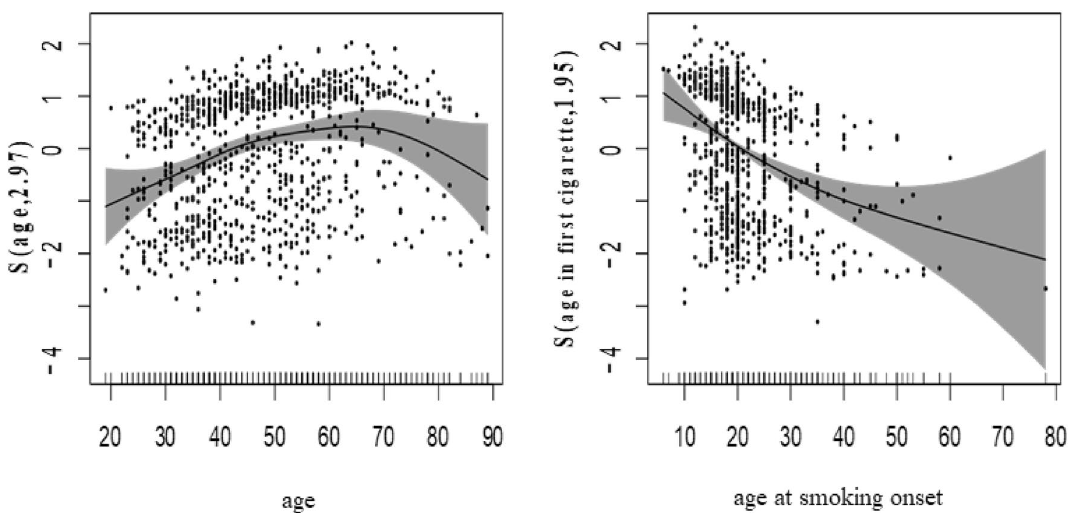
Figure 1. Estimating the smooth function of the relationship between: (left) age and smoking intensity, (right) age at smoking onset and smoking intensity. The numbers displayed in brackets in the y-axis title represent the edf of smooth curves. The linear predictor scale is used to present the results. The ‘rug plot’ at the bottom of each graph indicates the covariate values. The points on the graph are residuals. The grey region represents the Bayesian confidence interval of